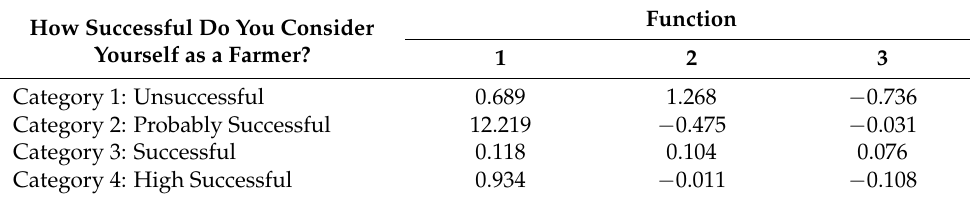
Table 9. Classification results: functions at group